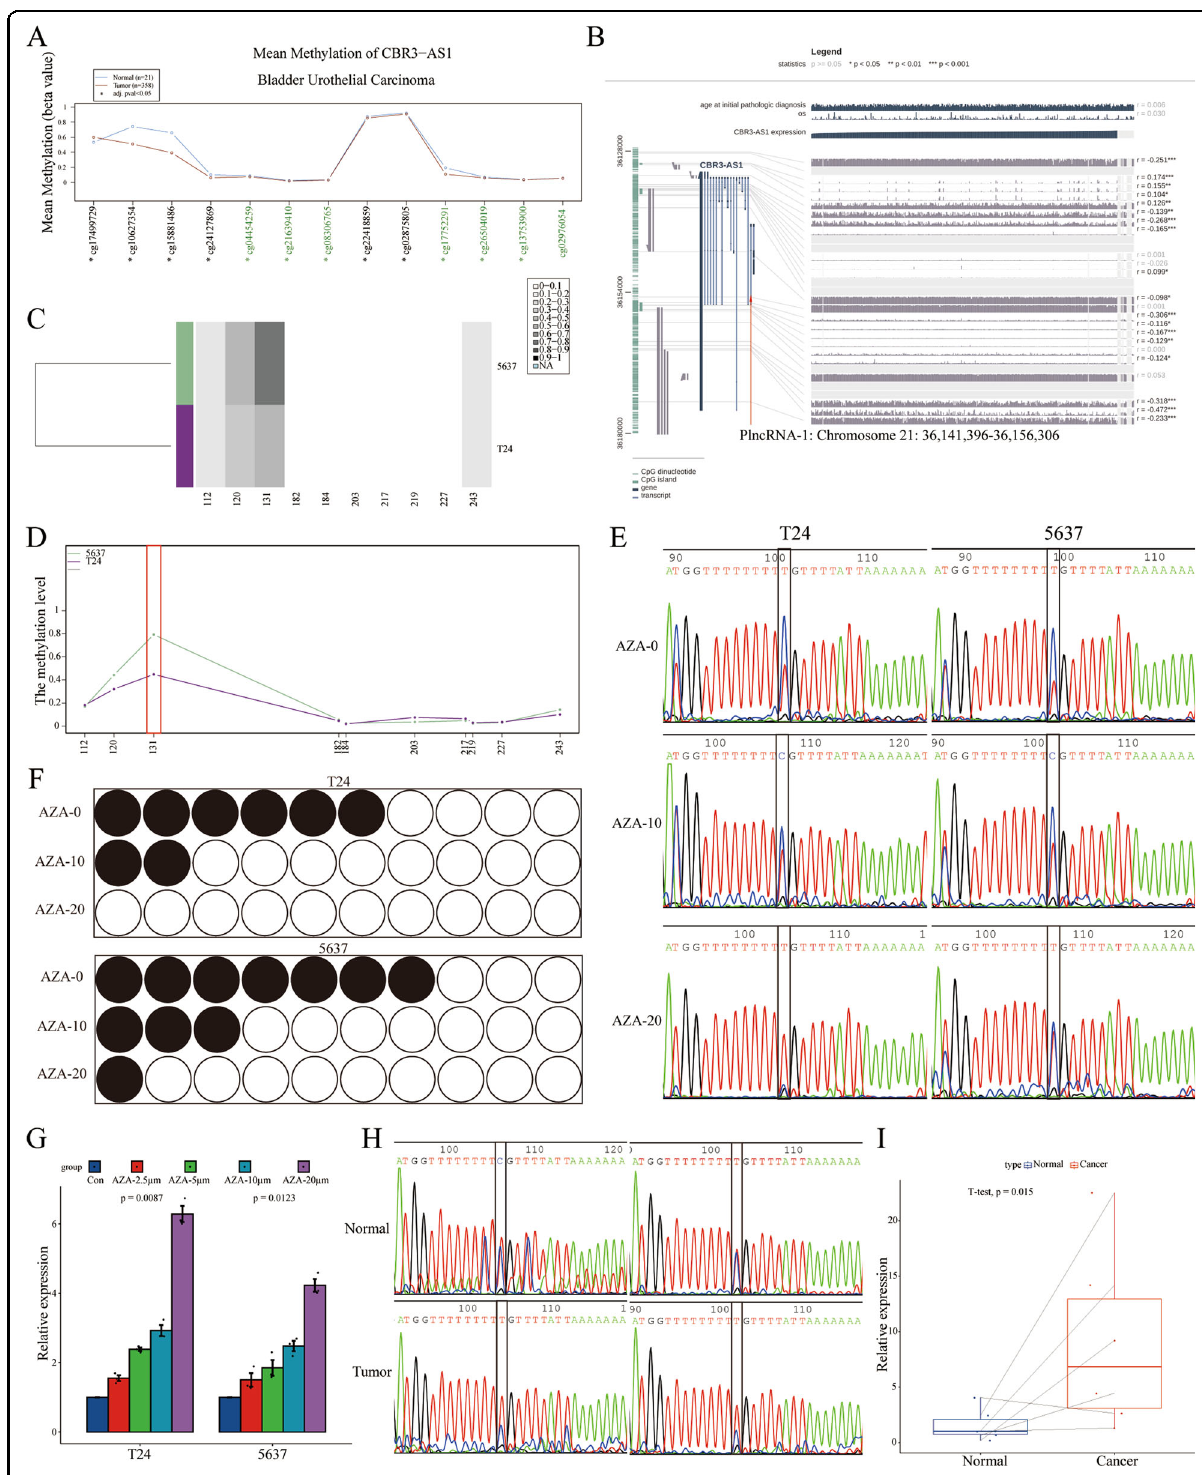
Fig. 4 Methylation level of PlncRNA-1 promoter. A Wander tool analysis for the degree of PlncRNA-1 promoter methylation in BC tissues. B MEXPRESS tool analysis for the relationship between the degree of PlncRNA-1 promoter methylation and its expression level in BC. C , D BSAS analysis for the degree of PlncRNA-1 promoter region methylation. E , F The effect of AZA treatment on the methylation level of PlncRNA-1 promoter at position 131. The red peak represents the base T, which is unmethylated. The blue peak represents the base C, which is methylated. Black dots represent methylation, whereas white ones represent unmethylation. G The expression level of PlncRNA-1 after treatment of BC cells with varied AZA concentrations. H Degree of PlncRNA-1 promoter region methylation in BC tissues. I The expression level of PlncRNA-1 in six pairs of normal and BC